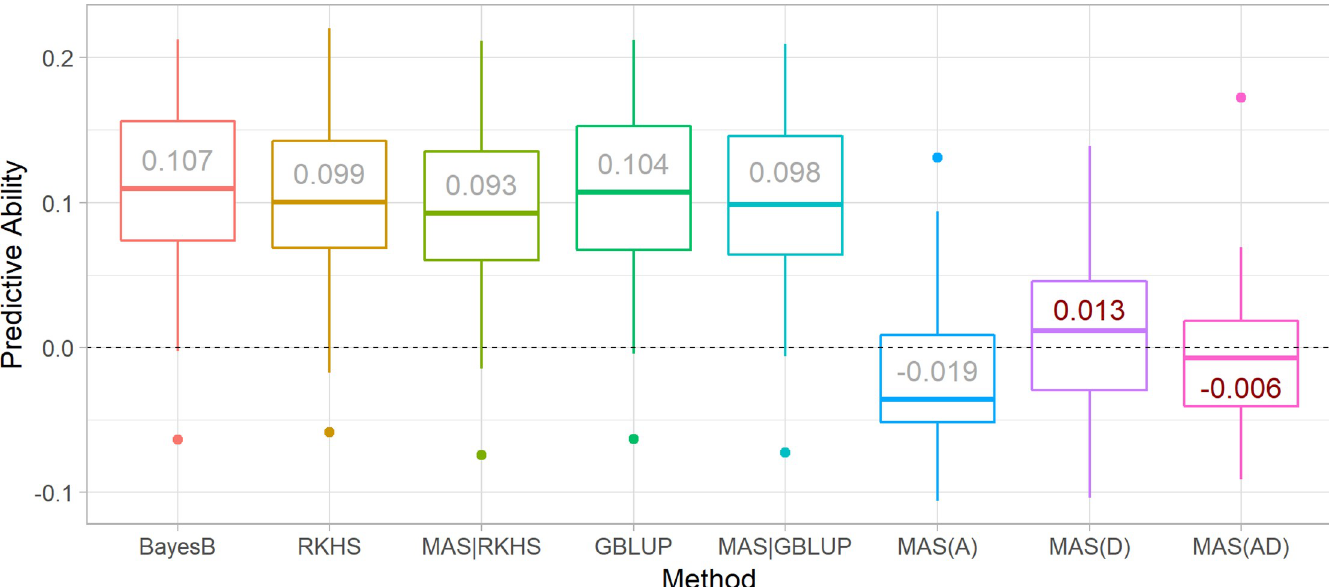
Fig 1. Predictive ability of LNTI in maize single-crosses using BayesB, RKHS, MAS|RKHS, GBLUP, MAS|GBLUP, additive MAS, dominance MAS, and additive + dominance MAS. The MAS is based on four markers identified as significantly associated with the trait in the parental inbred lines by Morosini et al. [18]. Values inside the boxes are mean correlations across 50 replicates. Red font indicates that the mean is not statistically different from zero by t-test .